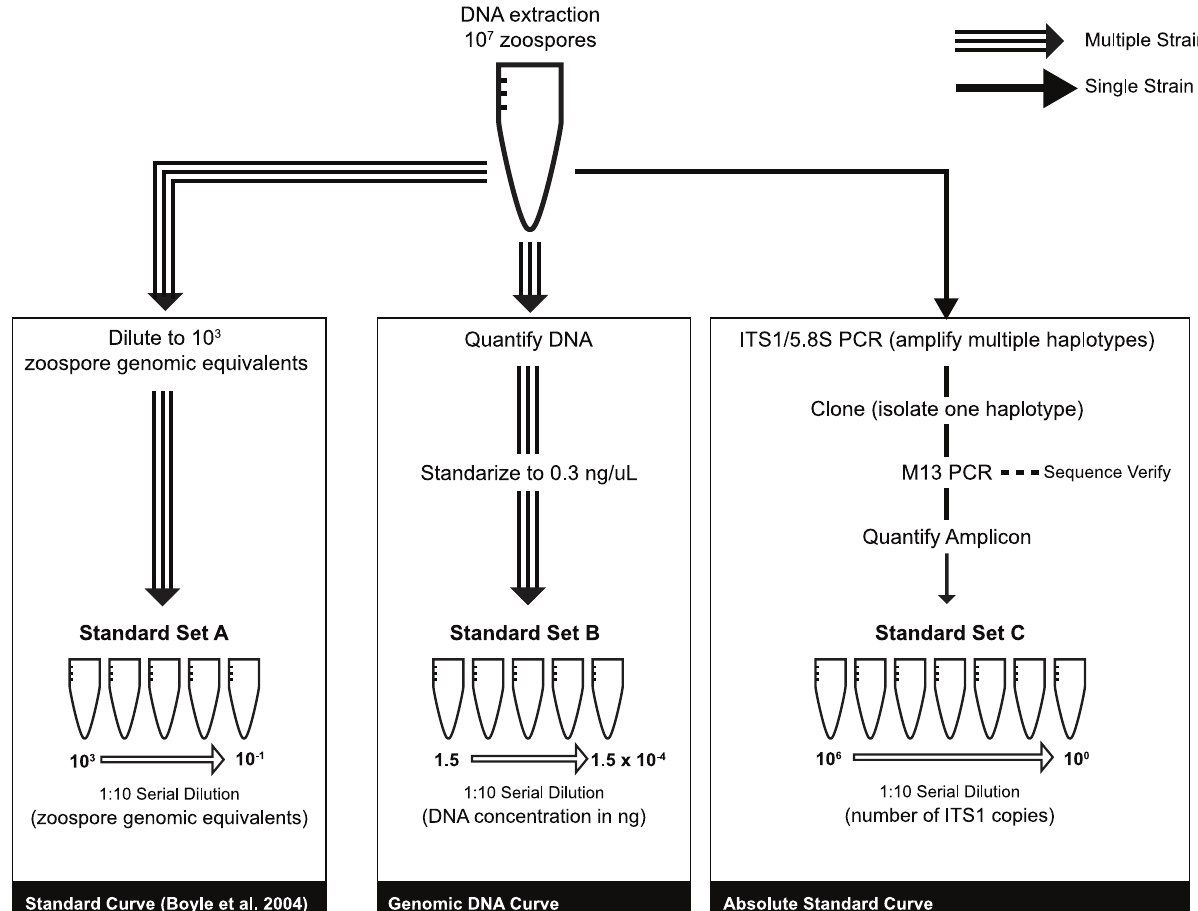
Figure 1. Schematic view of standard set preparations used in this study.